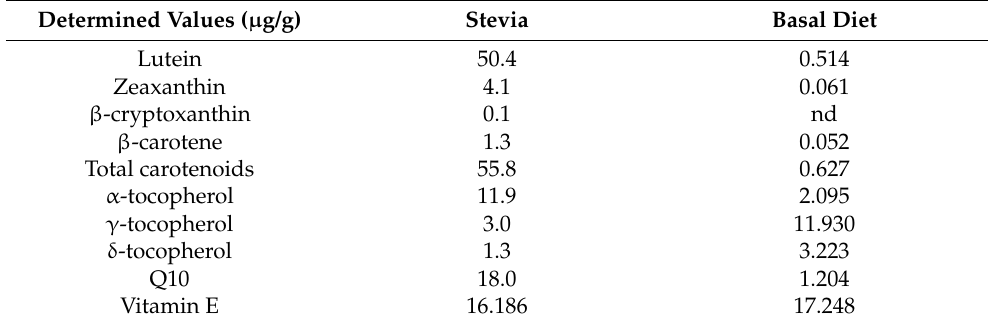
Table 2. Antioxidant composition of stevia and the basal diet (analyses were performed in duplicates). Determined Values ( µ g/g) Stevia Basal Diet